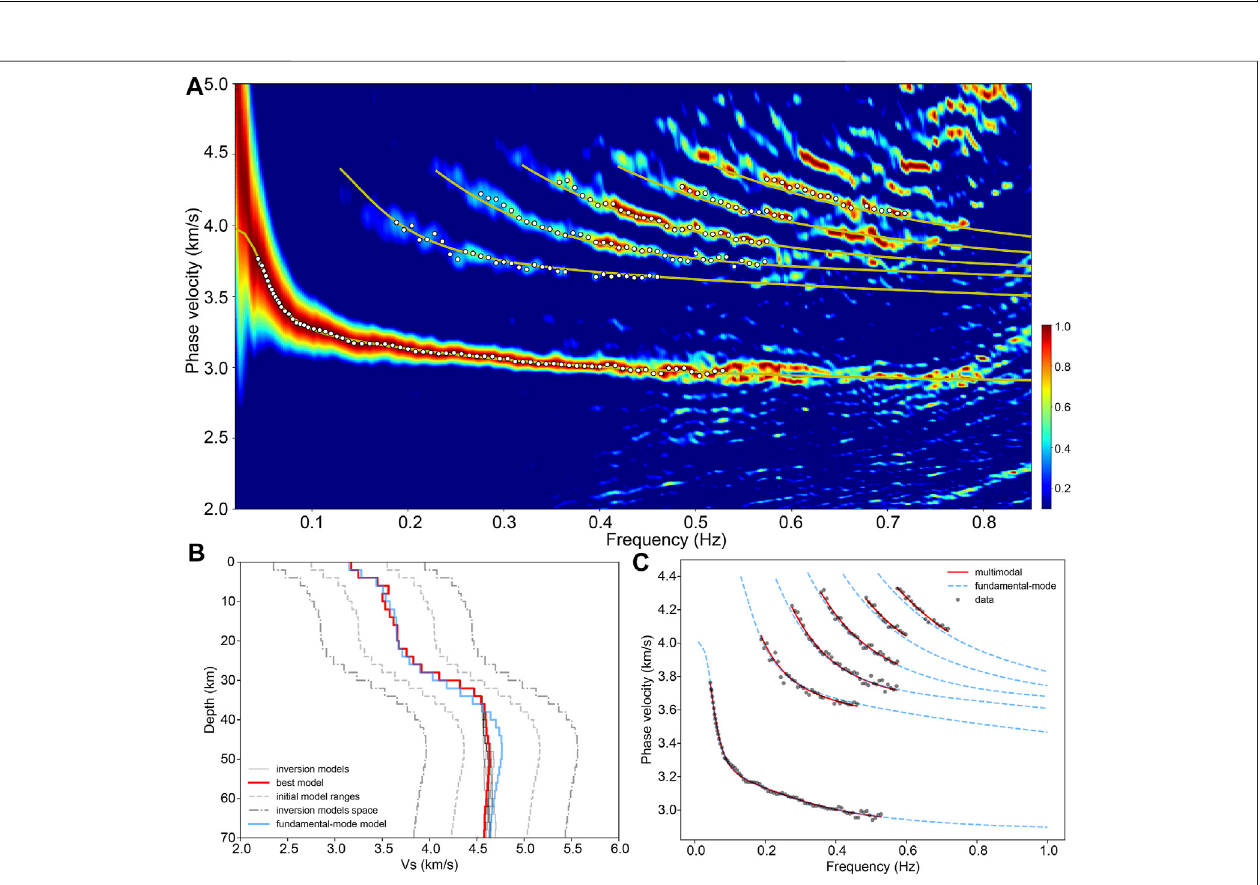
FIGURE 5 | Identi fi cation of the multimodal dispersion curves of array “ ZV ” and inversion results and fi tting results. (A) The F-J spectrogram of seismic array “ ZV ” . (B) and (C) The inversion and fi tting results of the multimodal dispersion curves.